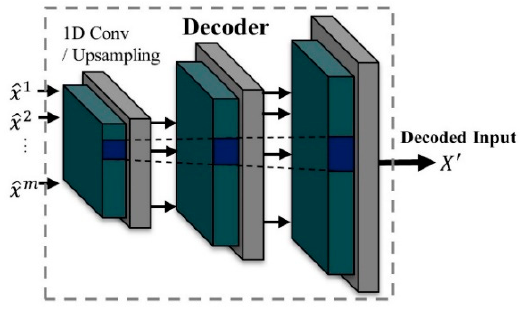
Figure 7. Decoding process for reconstructing the input. The reconstruction error